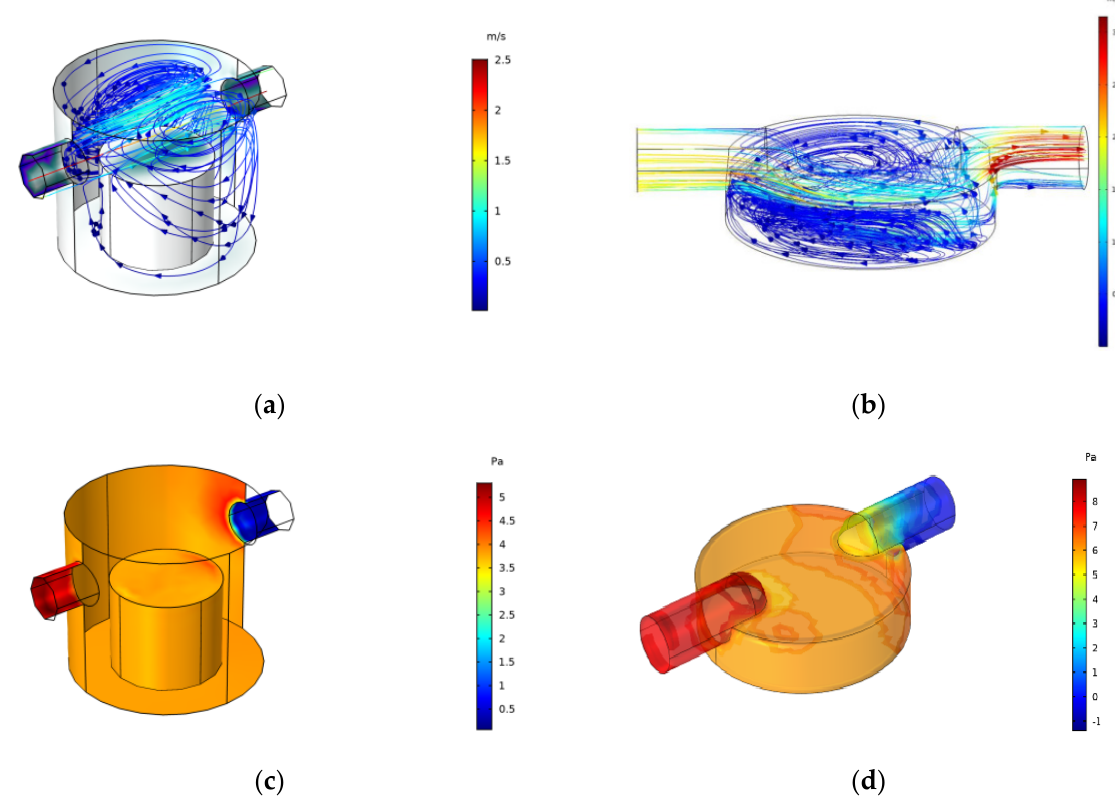
Figure 12. ( a ) Simulation results of velocity field in a cover cavity; ( b ) Simulation results of velocity field in a cap cavity; ( c ) Simulation results of pressure field in a cover cavity; ( d ) Simulation results of pressure field in a cap cavity.